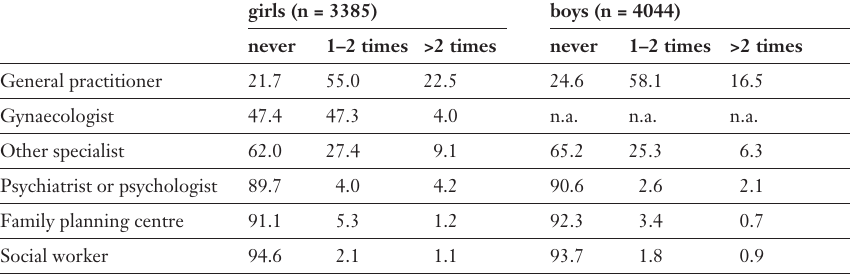
Different health care professionals or so- cial workers being consulted by adoles- cents over the last 12 months.